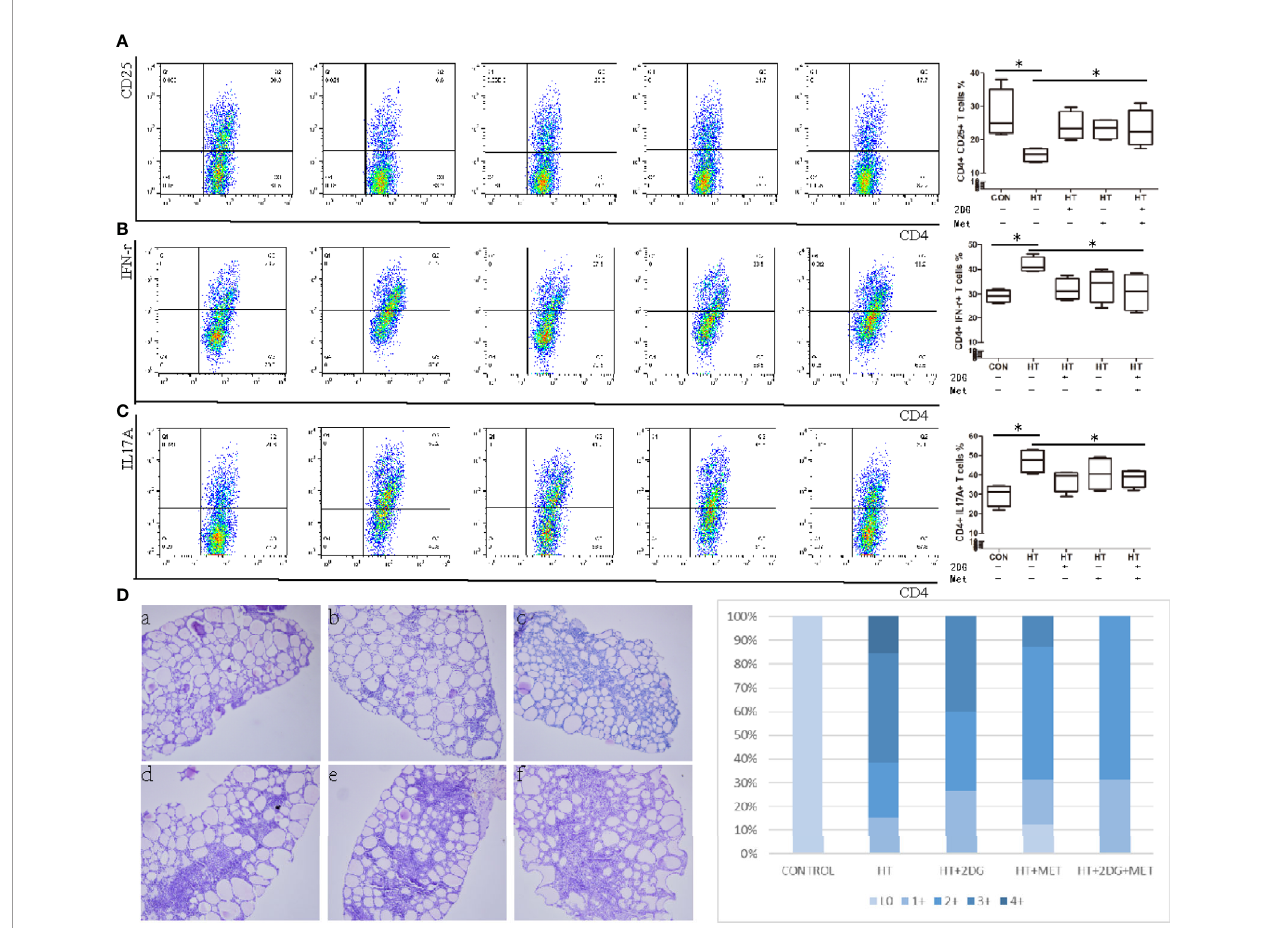
FIGURE 5 | Treatment with 2DG and/or metformin for 4 weeks reversed thyroiditis in SAT mice. SAT mice treated with 2DG, metformin, or combination, and spleen mononuclear cells were harvested, incubated, and evaluated by fl ow cytometry (n = 7 per group). Spleen mononuclear cells were incubated and the subtype of CD4+ T cells including CD4+CD25+ Tregs T cells (A) , CD4+IFN g + Th1 T cells (B) , CD4+CD17A+ Th17 T cells (C) were measured by fl ow cytometry. The severity of SAT, indicated by proportions of high and low severity scores, was evaluated (D) . Severity score: 0(a), 1+(b), 2+(c), 3+(d), 4+ (e, f). *p <